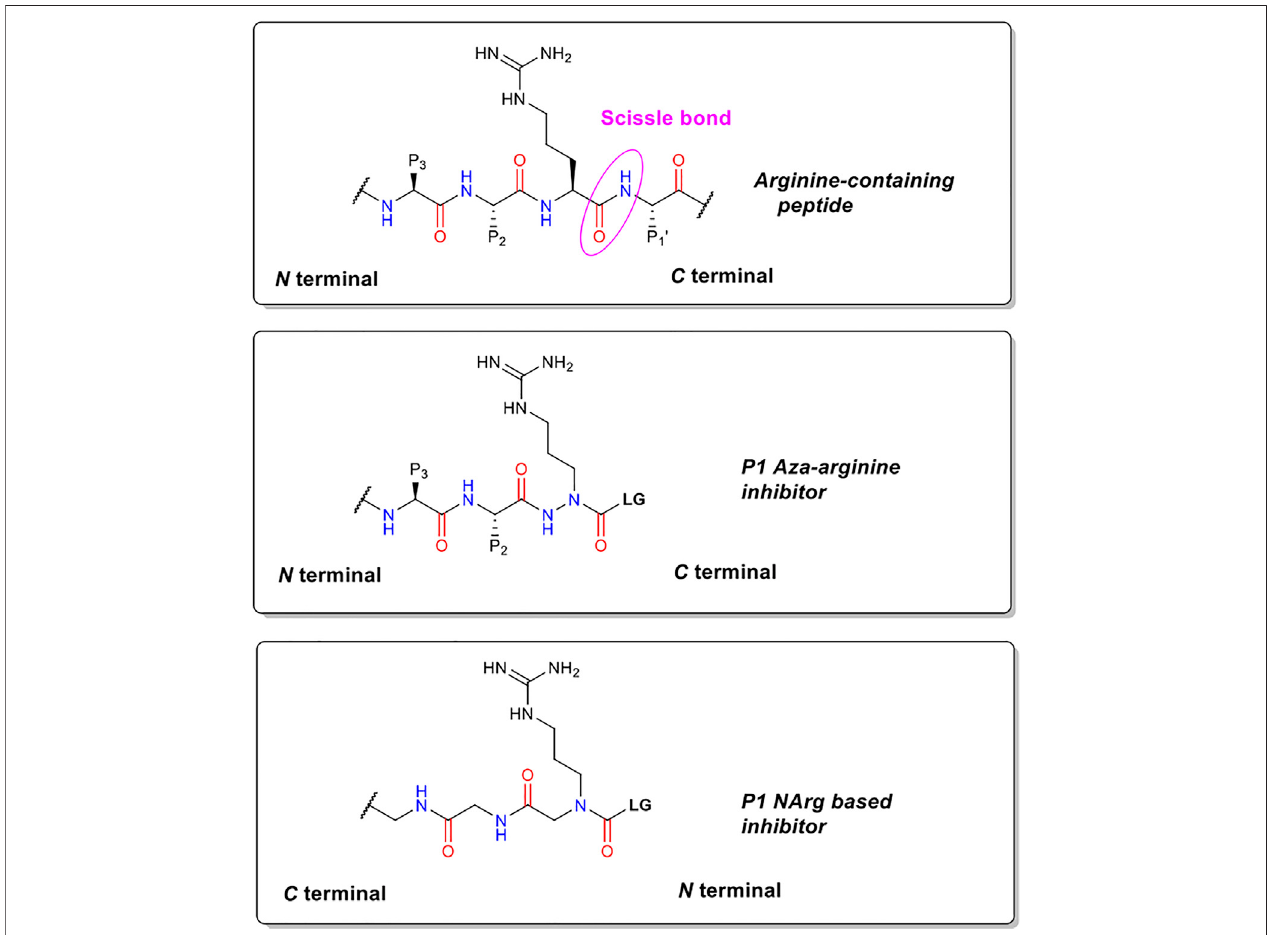
FIGURE 4 | Structural comparisons of P1 NArg inhibitors with standard trypsin substrates and P1 aza-arginine containing inhibitors.